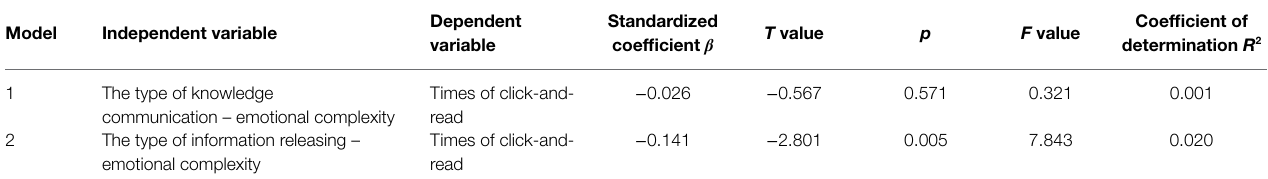
TABLE 4 | Regression analysis results of the impact of the emotional complexity of the tweet title on audience’s click-and-read behavior. Model